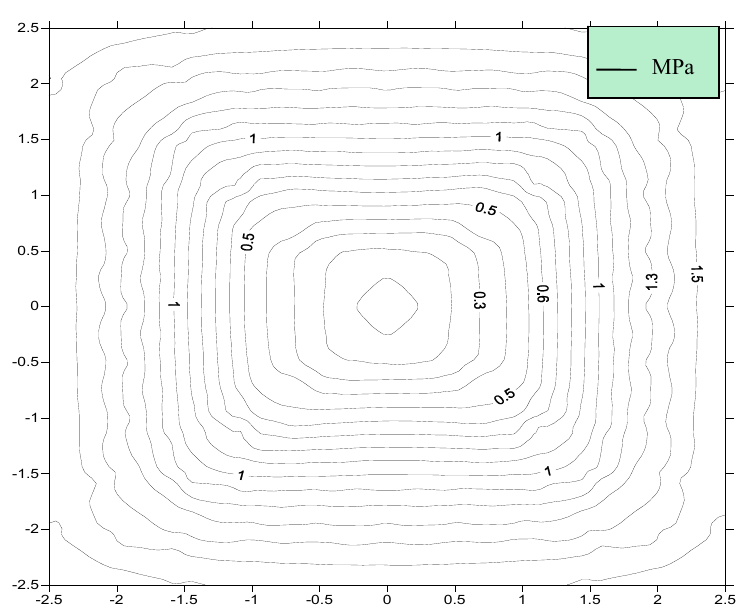
= 350 K, the distribution of gas pressure around boreholes. Energies 2019 , 12 , x FOR PEER REVIEW